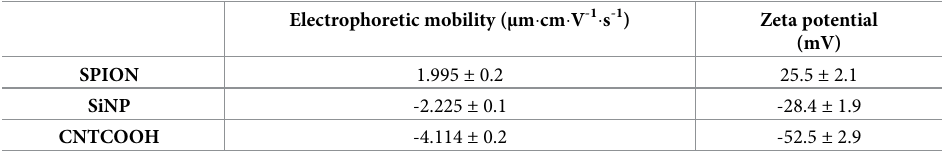
Table 1. Determination of NP stability in MilliQ water by z -potential